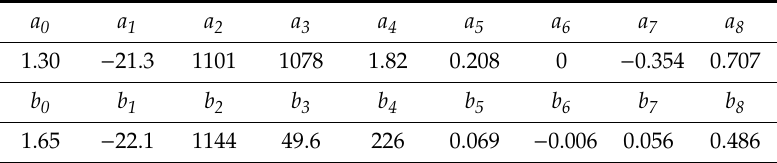
Table 2. Fitting parameters of the ‘Magic